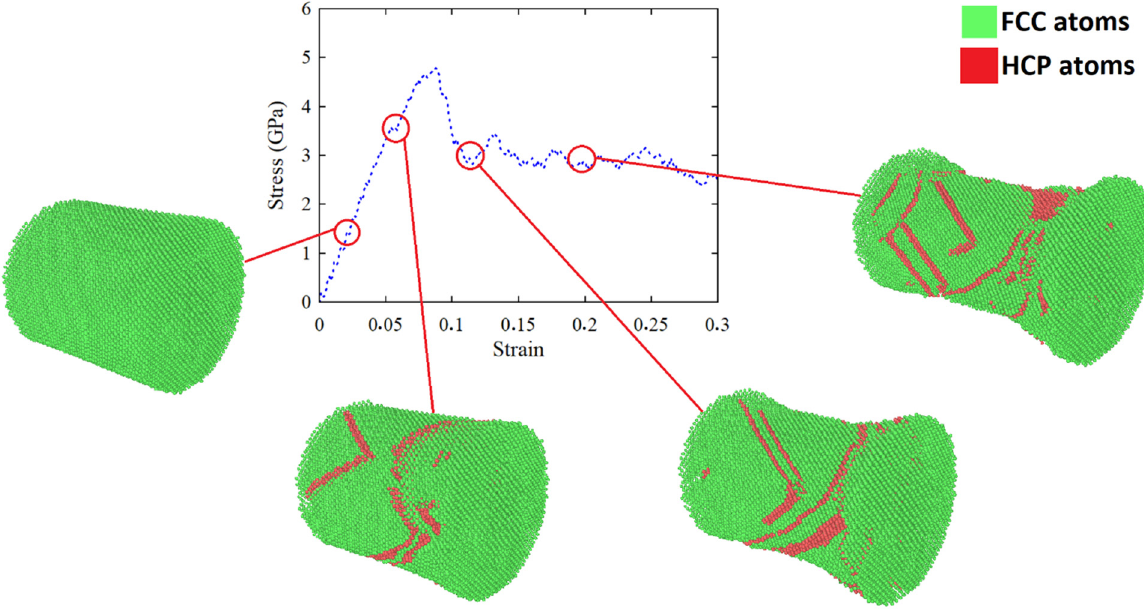
Figure 5: Evaluation of crystalline structural changes before and after yielding